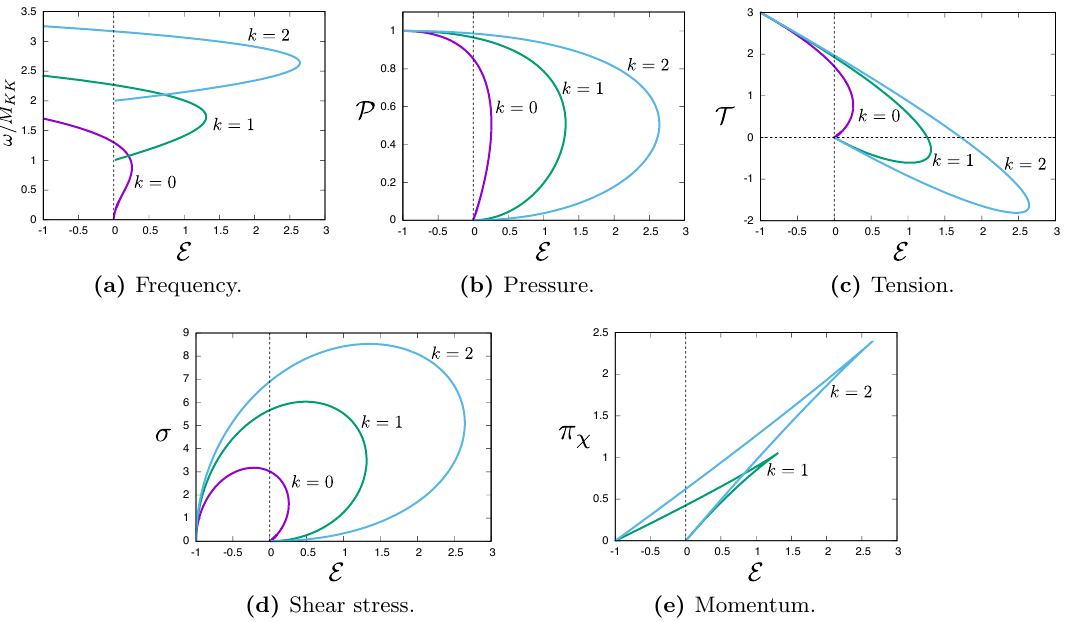
Figure 2. Physical quantities of the resonating AdS soliton as a function of the energy